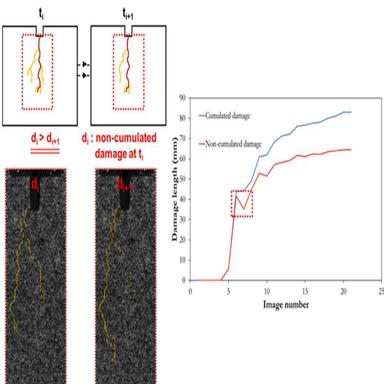
Example of local strain decrease leading to artificial crack closure during a WST and cumulated damage measured by 2P-DIC which is not affected.